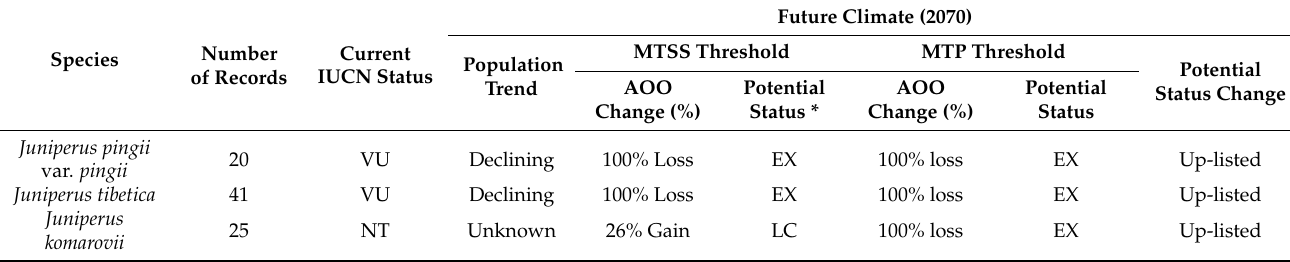
Table 2. Current and proposed extinction risk (conservation status) and area of occupancy (AOO) changes under current and future (2070) potential distributions for the target Juniperus species in the representative concentration pathway (RCP) 4.5 and RCP8.5 scenarios and assuming either limited dispersal or full dispersal scenarios: changes in the projected AOO were based on MTSS and MTP.